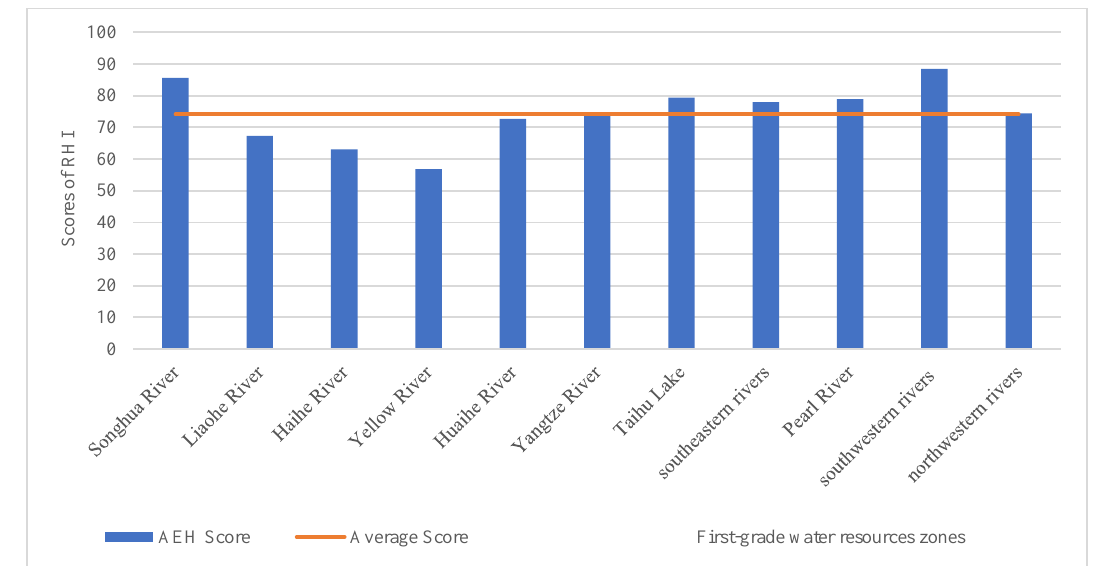
Figure 6. AEH evaluation results for China’s first -grade water resource zones.